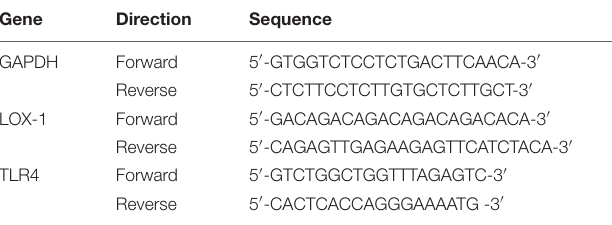
TABLE 1 | RT-PCR primers for